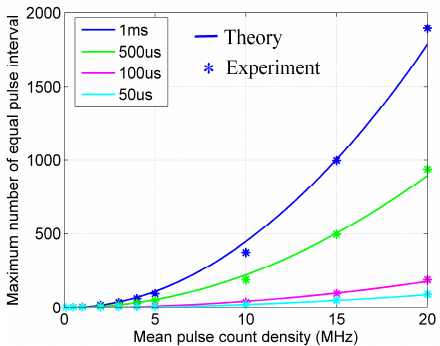
Figure 7. Maximum number of the same pulse interval.